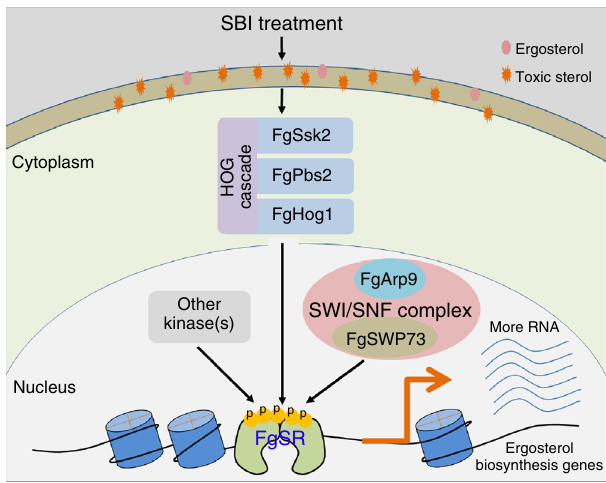
Fig. 10 A proposed model for the regulation of sterol biosynthesis mediated by FgSR in F. graminearum . Under the treatment with sterol biosynthesis inhibitors (SBIs), the HOG cascade FgSsk2-FgPbs2-FgHog1 is activated in F. graminearum . Subsequently, FgSR is strongly phosphorylated by activated FgHog1 and other kinase(s). The highly phosphorylated FgSR recruits the SWI/SNF complex to remodel chromatin, and subsequently induces